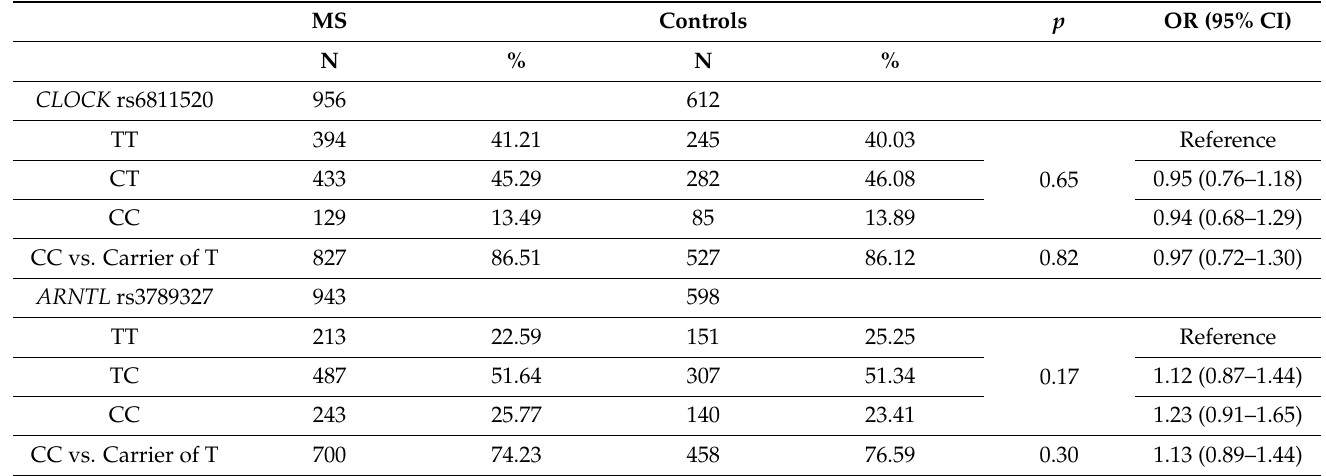
Table 2. Genotype distribution and case-control association study of CLOCK rs6811520 and